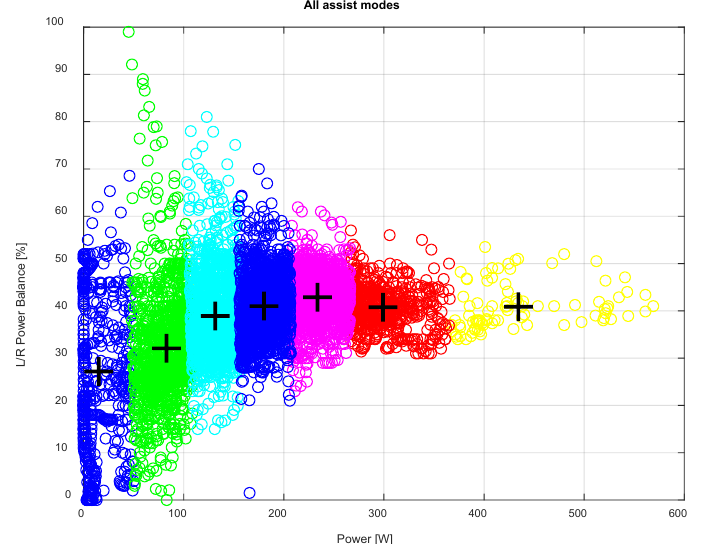
Figure 12. Left/right power balance as a function of power.